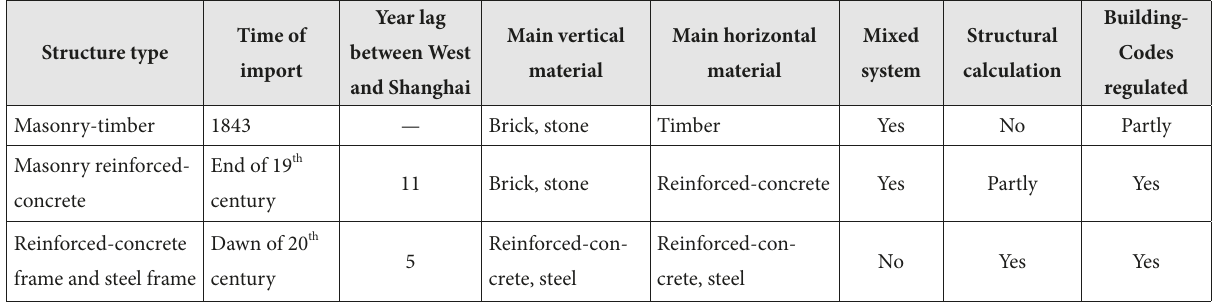
Table 1 Main information of different structure types (Source: the